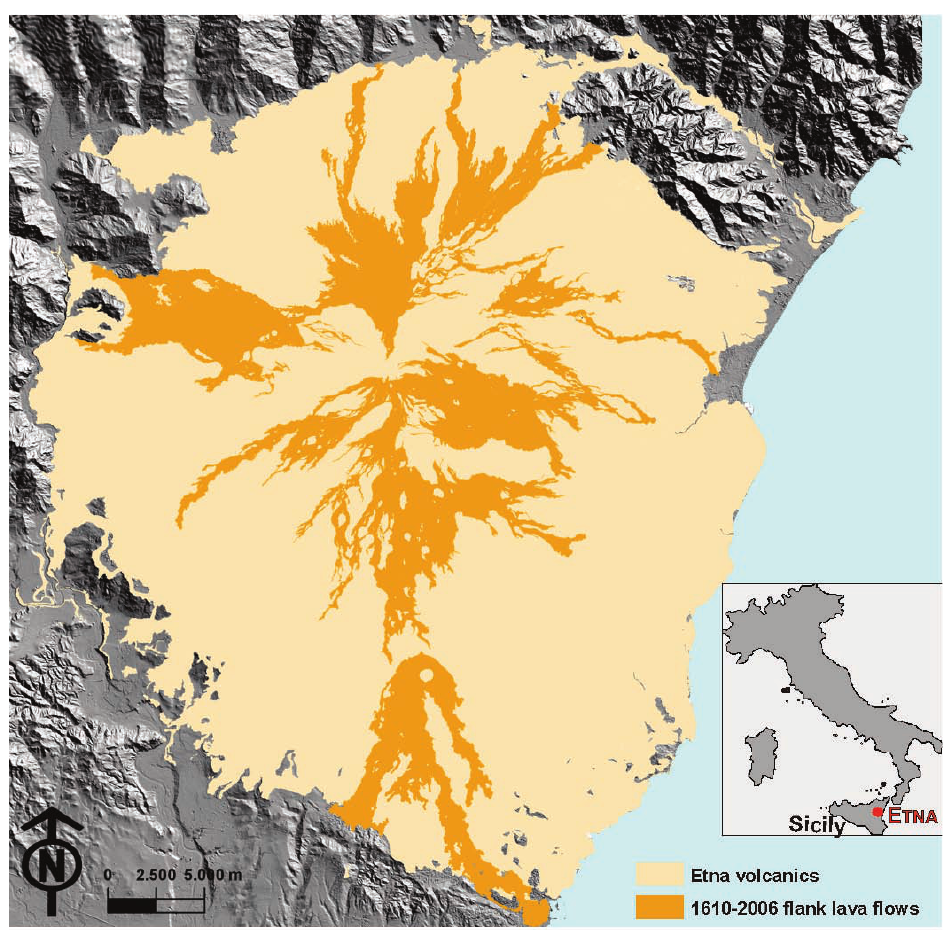
Figure 1. Etna flank lava flows over the last 400 years mapped from the NGM (orange) and Etna volcanics (beige) Inset: location of Mount Etna (red dot) with respect to Sicily and